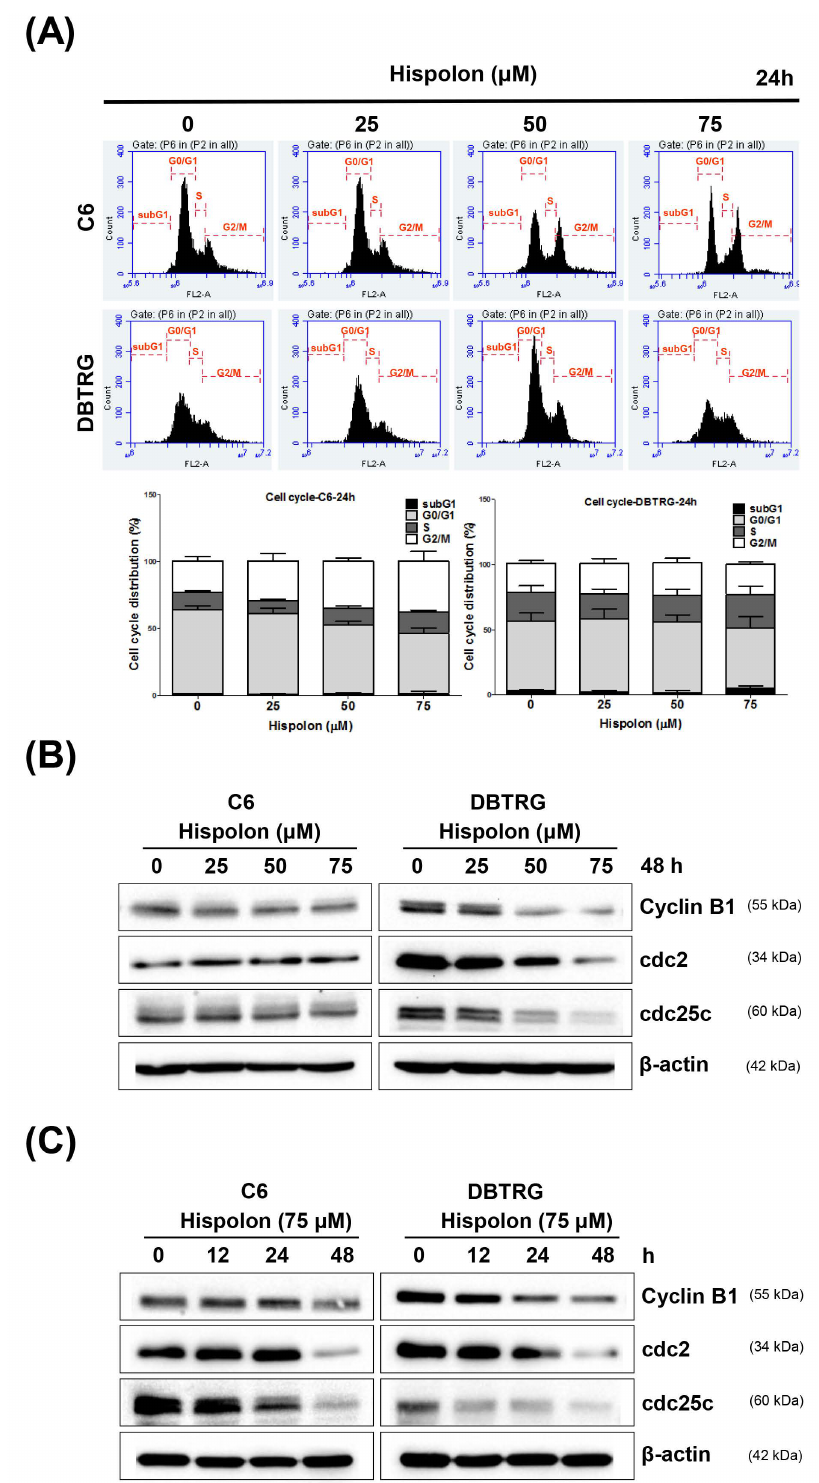
Figure 2. Hispolon-induced cell cycle G2/M arrest in GBM cells. ( A ) GBM cells were incubated with various concentrations of hispolon for 24 h and then subjected to PI staining followed by flow cytometry analysis. ( B ) GBM cells were treated with an increasing concentration of hispolon for 48 h, and the cell cycle regulatory proteins cyclin B1, cdc2, and cdc25c were analyzed using Western blotting. ( C ) GBM cells were treated with 75 µ M hispolon for 12, 24, and 48 h, and the cell cycle regulatory proteins cyclin B1, cdc2, and cdc25c were analyzed using Western